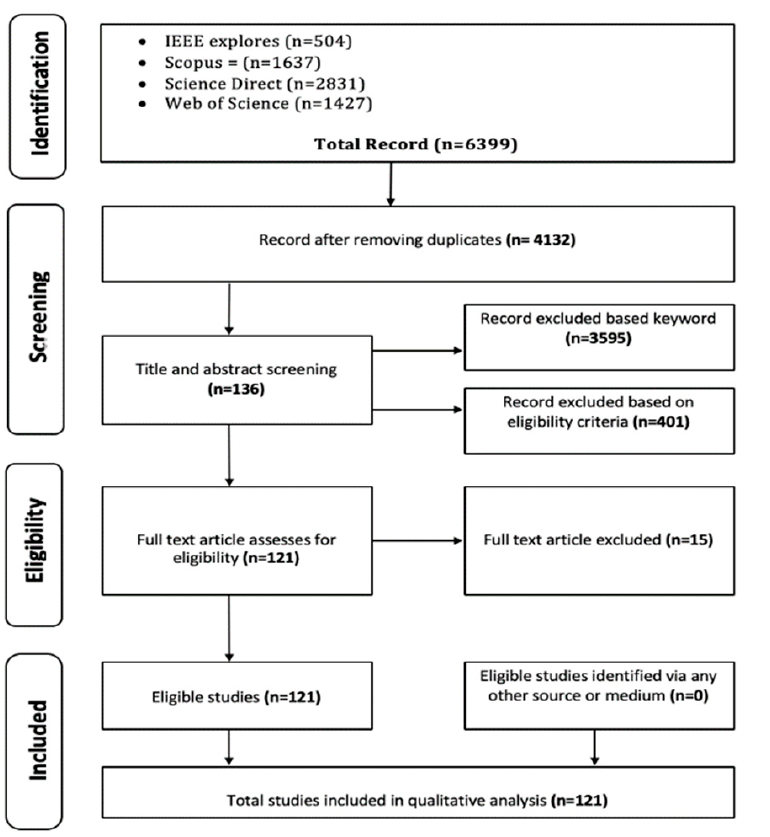
Figure 3. Paper search and selection process.